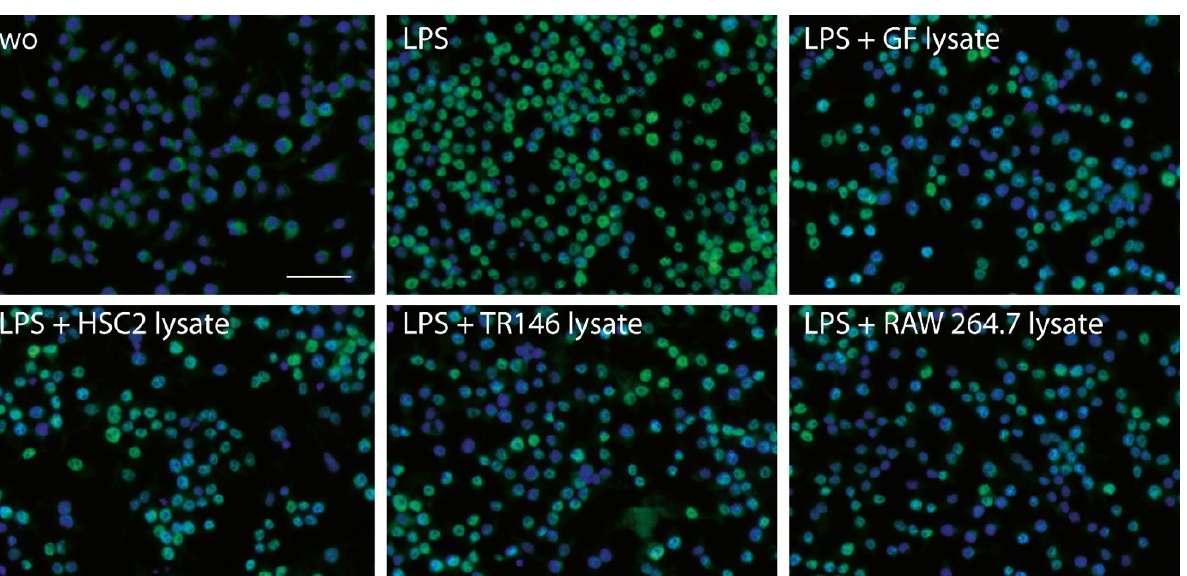
Figure 4. Sonicated necrotic cell lysates reduce TLR3 agonist-induced inflammation of RAW264.7 macrophages. RAW264.7 cells were exposed to necrotic cell lysates from gingival fibroblasts (GF), HSC2, TR146 (TR), and RAW264.7 (RAW) prepared by sonication in the presence of 10 µg/mL poly (1:C) HMW. The data show the x-fold changes in IL1 and IL6 gene expression and the release of IL6 protein into the supernatant. Data points indicate independent experiments. Statistical analysis was based on a Friedmann test and p -values are indicated.